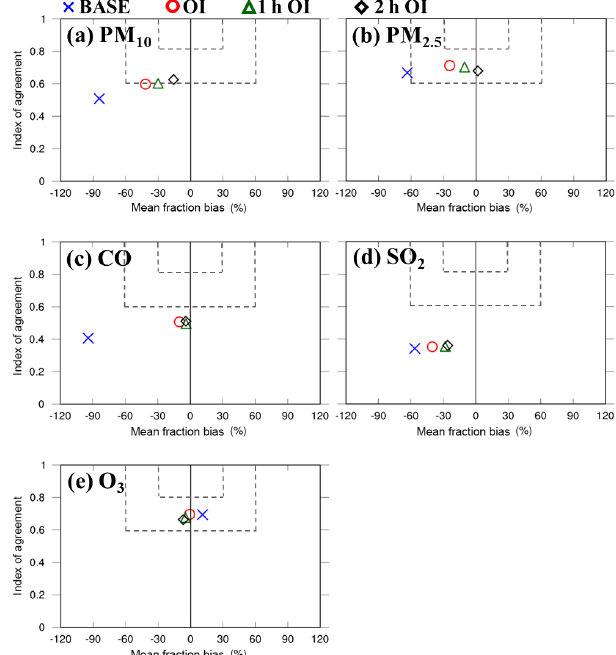
Figure 13. Soccer plot analyses for (a) PM 10 , (b) PM 2 . 5 , (c) CO, (d) SO 2 and (e) O 3 . The CMAQ-predicted concentrations were compared with the Air Korea observations. Blue crosses, red cir- cles, dark-green triangles and black diamonds represent the perfor- mances calculated from the BASE RUN, the DA RUNs with the OI system, the 1h OI system and the 2h OI system,